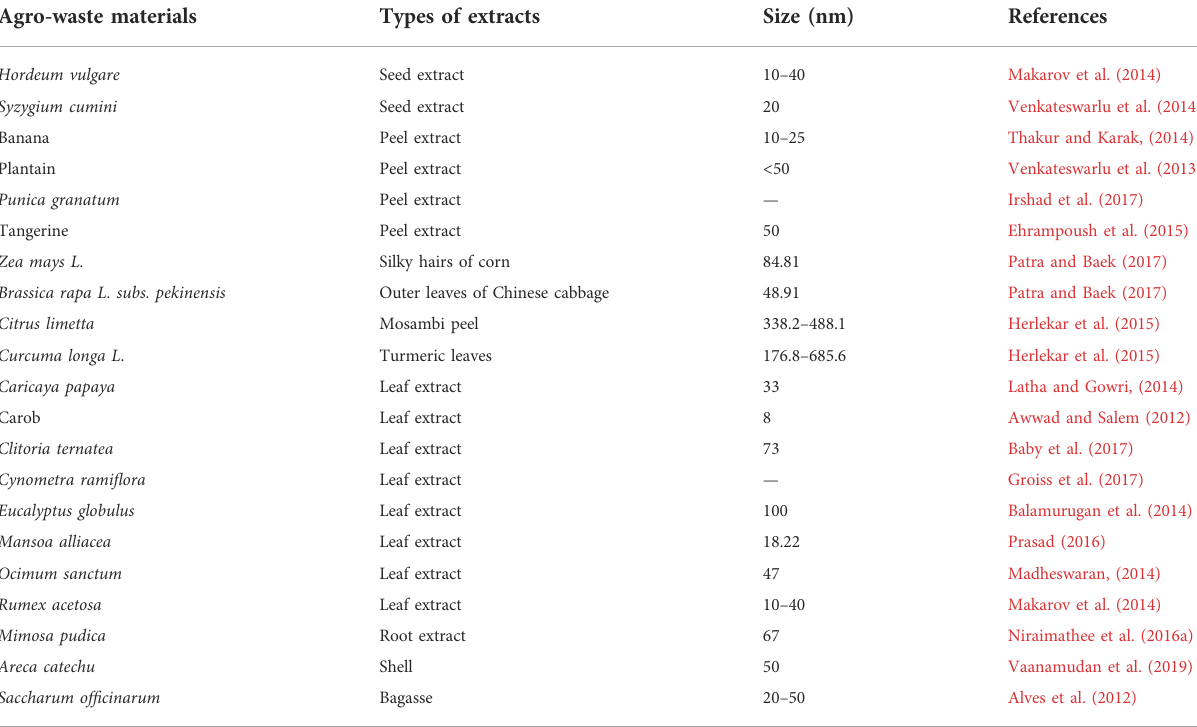
TABLE 1 Types of agro-waste extracts used to produce nanostructured iron